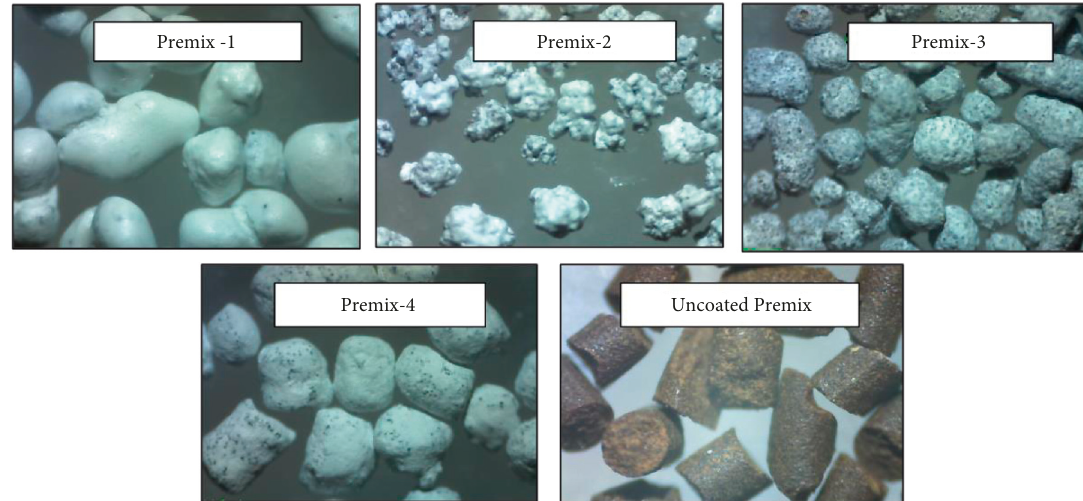
Figure 3: Light microscopic images of Indian iron premixes 1–3, UofT positive control 4, and uncoated extruded ferrous fumarate.